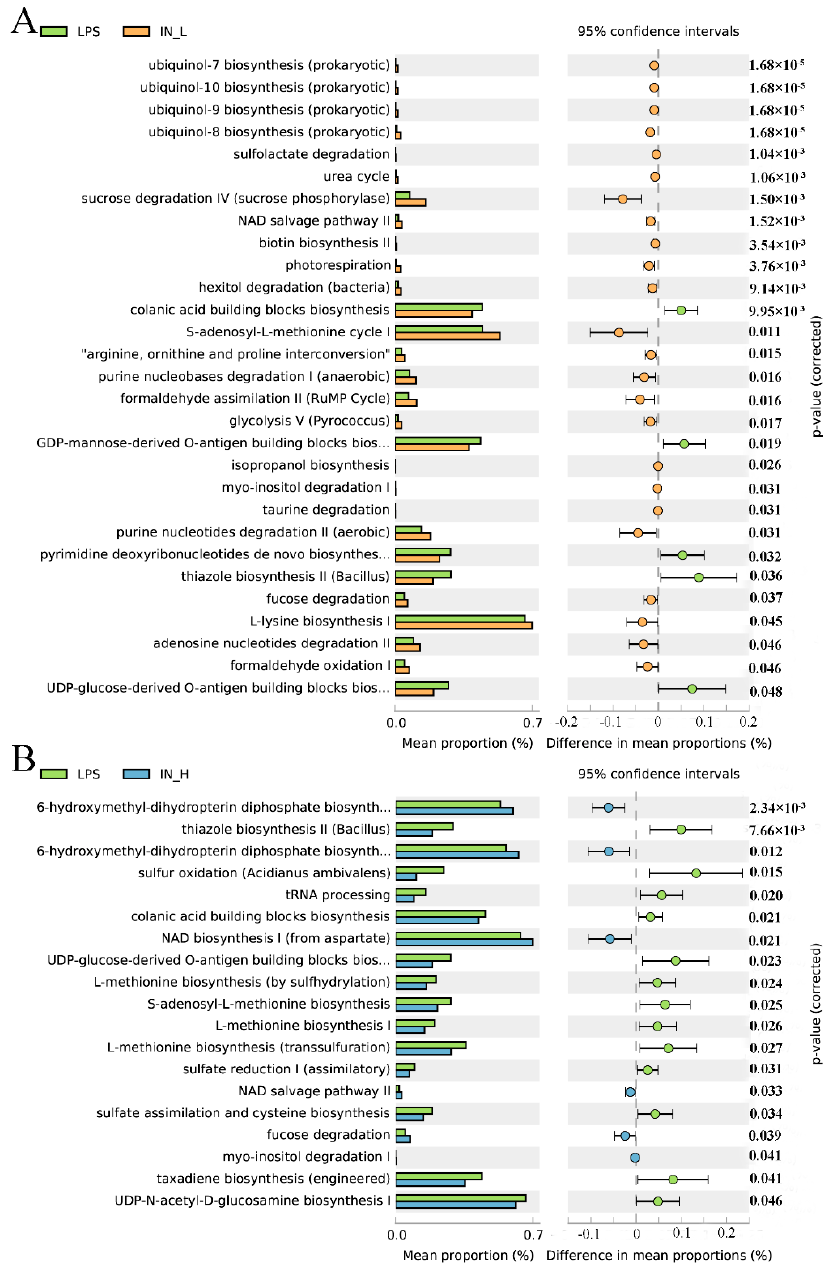
Figure 5. KEGG level 3 metabolic pathways: The remarkable differences in metabolic pathways between the LPS group and the IN-L group ( A ), and between the LPS group and the IN-L group ( B ). 3.5. Associations between the Intestinal Microbiota and the Biochemical Indices Related to Lung